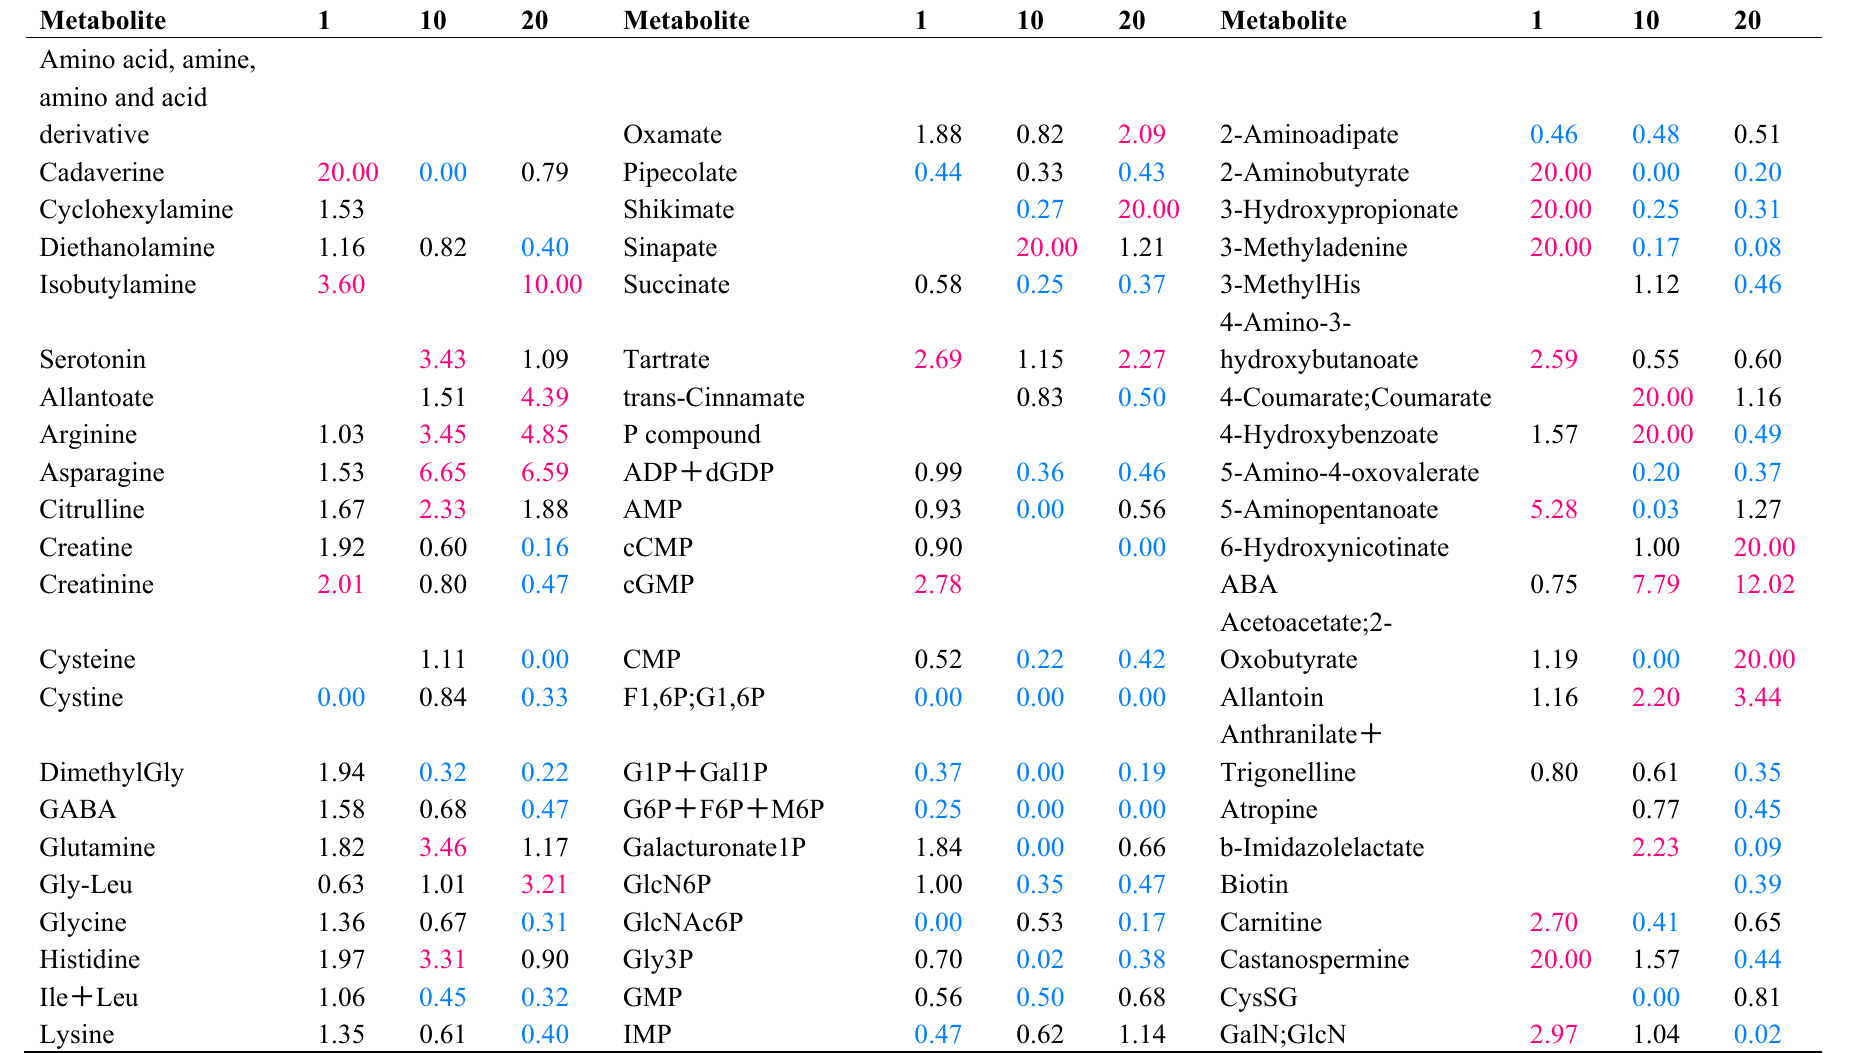
Table 2. Fold change (0 (P0) mg P L − 1 /P8) of the relative peak area of metabolites detected in root exudates of common bean 1, 10 and 20 days after transplanting. Metabolites that have a fold change >2.0 (pink) and < 0.5 (blue) are